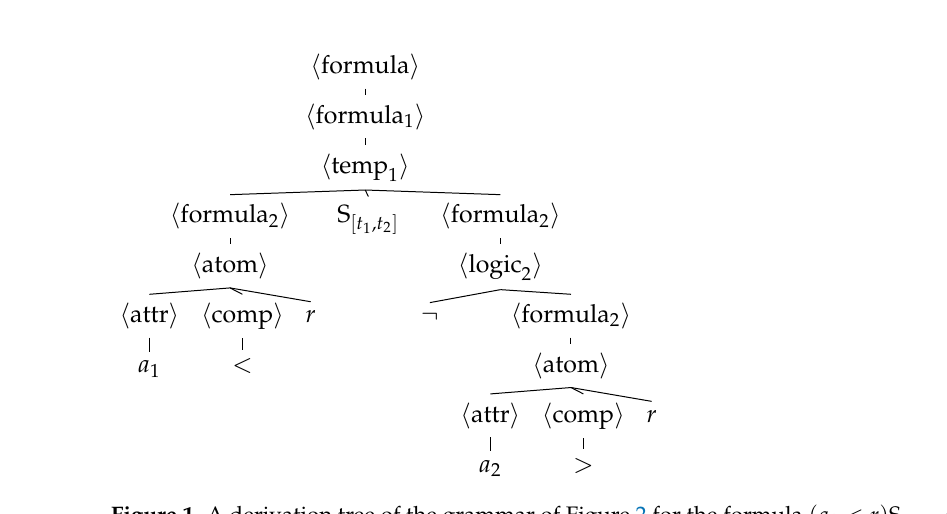
Figure 1. A derivation tree of the grammar of Figure 2 for the formula ( a 1 < r ) S [ t